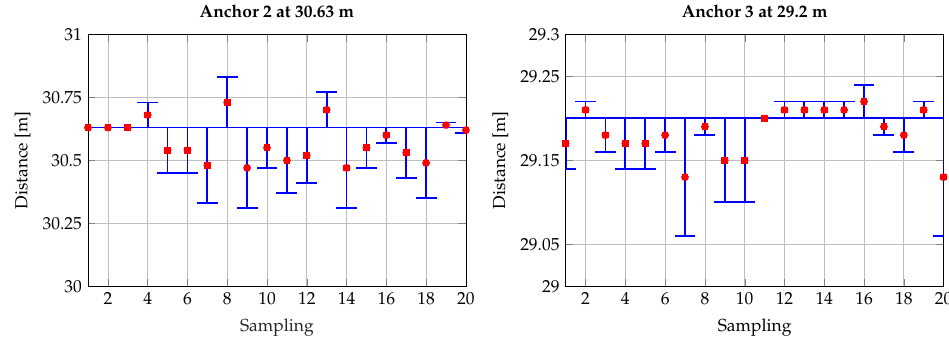
Figure 6. Experimental distance measurement in scenario 1 with one tag node and four anchor nodes anchor 0 , anchor 1 , anchor 2 , and anchor 3 . (red point: meaured distance, blue line: distance deviation).